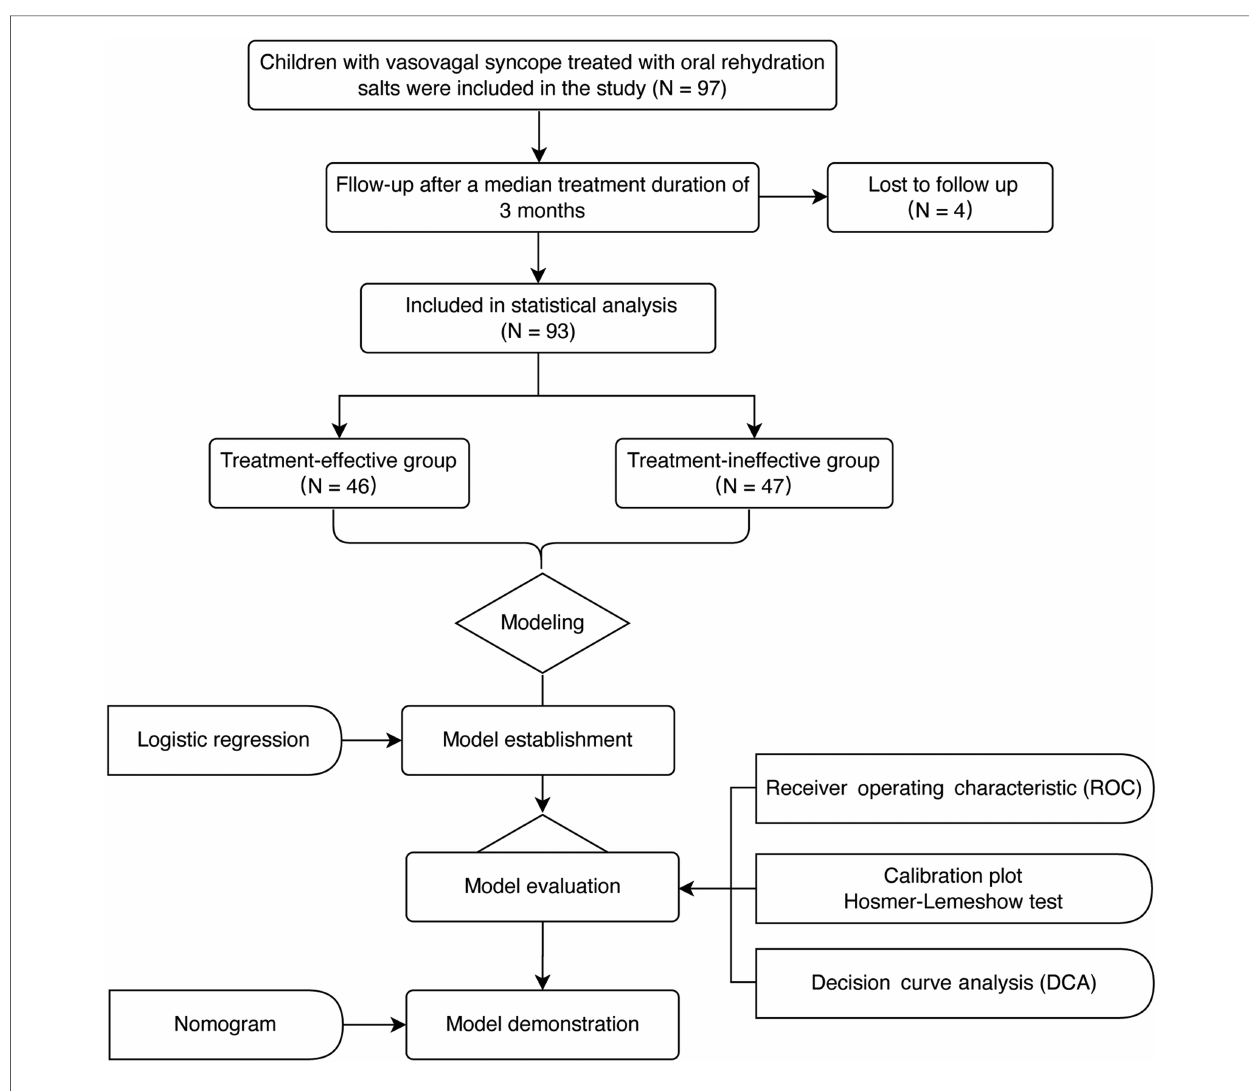
FIGURE 1 The fl owchart of the